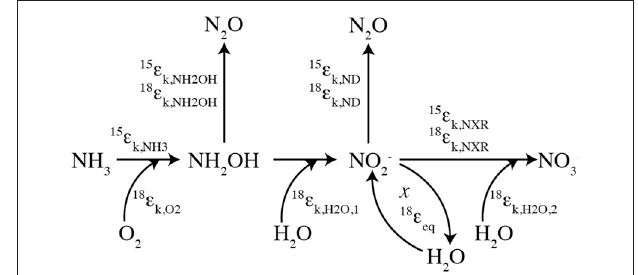
FIGURE 1 | Isotopic systematics for nitrification. A schematic of the isotopic systematics for ammonia oxidation and nitrite oxidation during nitrification. The kinetic isotope effects for ammonia oxidation ( 15 ε k , NH3 ) and nitrite oxidation ( 15 ε k , NXR and 18 ε k , NXR ) characterize the isotopic fractionation for the main N transformation processes while isotopic fractionation during oxygen atom incorporation ( 18 ε k , O 18 ε k , H ) controls the oxygen isotopes incorporated by the central 2 O , 2 pathway. Oxygen isotope exchange during ammonia oxidation and/or post-production abiotic exchange ( x ) may also play a role through the equilibrium fractionation ( 18 ε eq ) associated with it. N 2 O production occurs with N and O fractionation through decomposition of hydroxylamine